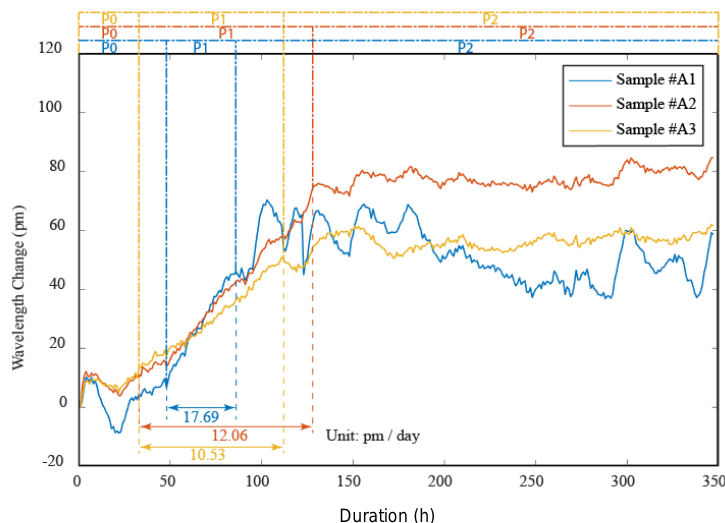
Figure 14. Bragg wavelength of embedded FBG sensors with wire arc sprayed Al-Zn coating with linear increase part marked. Table 5. Corrosion rate of tested wire arc sprayed Al-Zn coated samples.